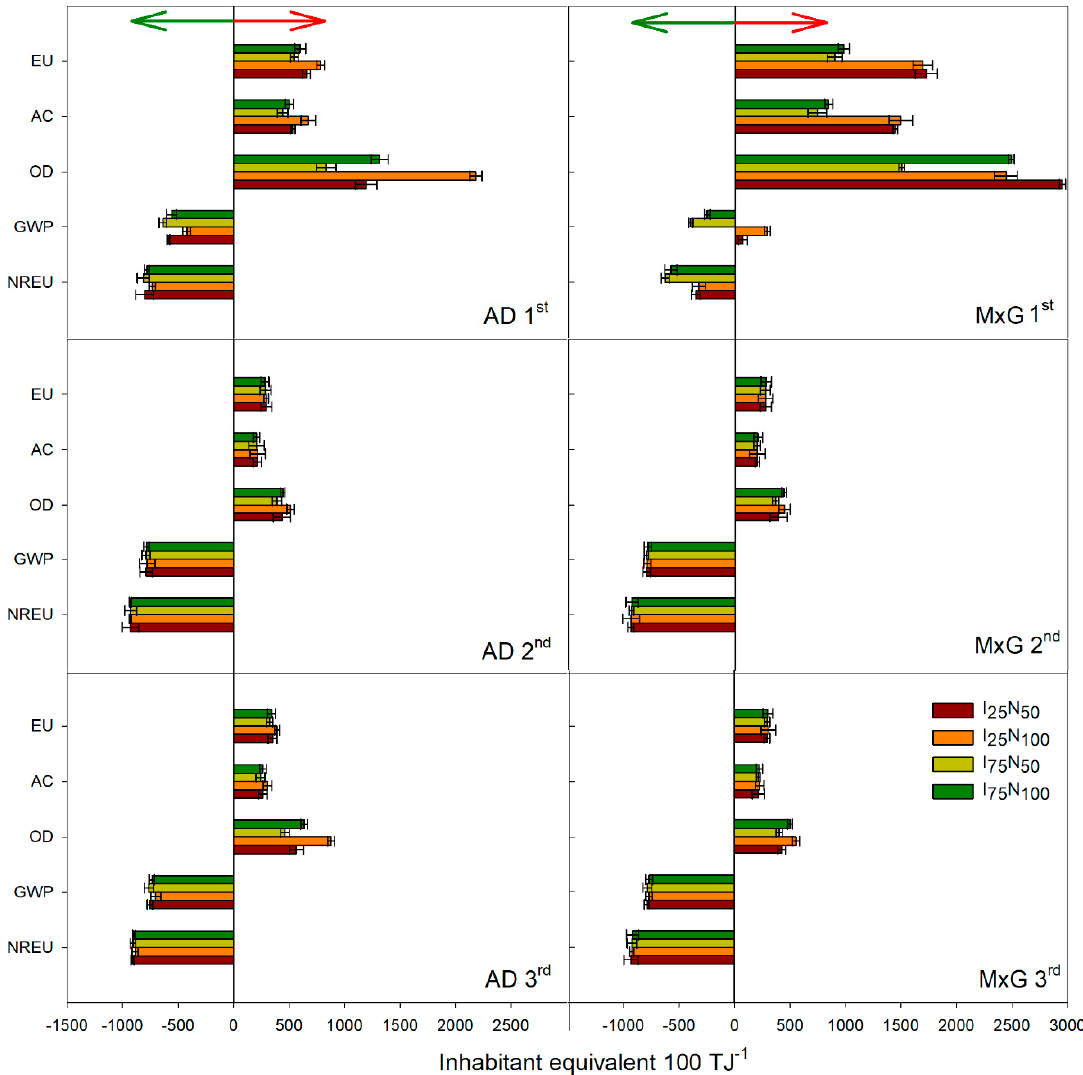
Figure 4. Impact categories (NREU—non-renewable energy use; GWP—global warming potential; OD—ozone depletion; AC—acidification; EU—eutrophication), expressed in European inhabitant equivalent per 100 TJ of energy consumed in one year, of Arundo donax and Miscanthus × giganteus throughout the experimental period and investigated main effects (green arrow—environmental benefits; red arrow—environmental burdens).